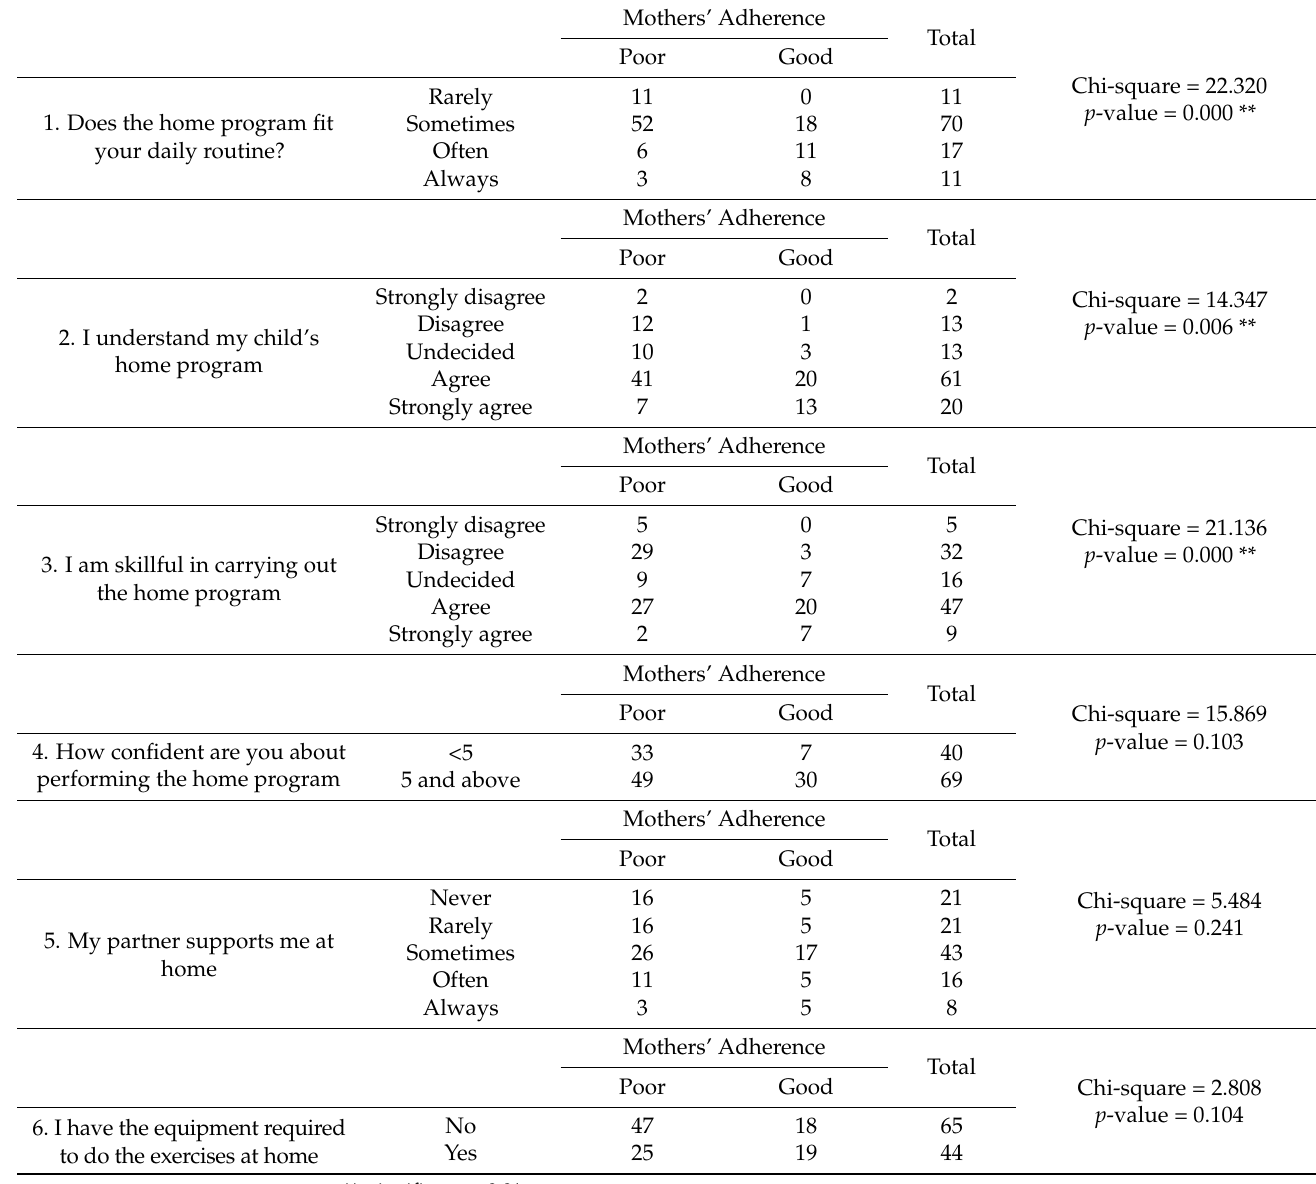
Table 4. Relation between mothers’ adherence and their experience.